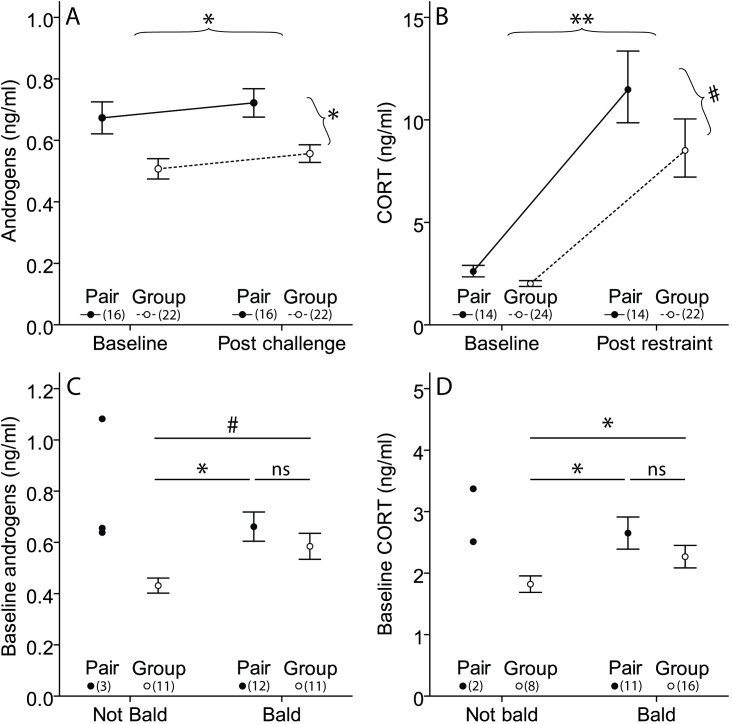
Plasma hormones.(A) plasma androgen concentration in ng/ml before and 30 minutes after an injection with 5 μg GnRH. (B) plasma CORT concentration in ng/ml before and after being restrained for 10 minutes (backtransformed from Log10). (C) baseline plasma androgen concentration and (D) baseline plasma CORT concentrations in ng/ml of bald and non-bald pair-housed females, and bald and non-bald group-housed females. Data from bald pair-housed females are indicated by solid circles, but were not used in the statistical analyses. Data are shown as means ± 1 SEM. Numbers between brackets indicate sample sizes. ** = p < 0.01; * = p < 0.05; # = p < 0.1; ns = not significant.